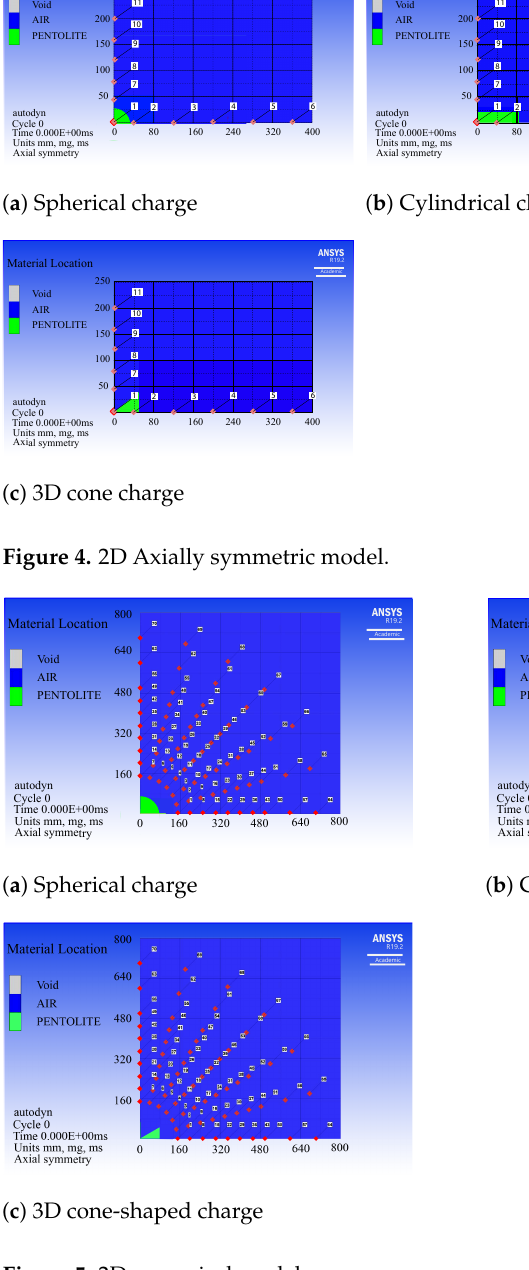
Figure 5. 2D numerical